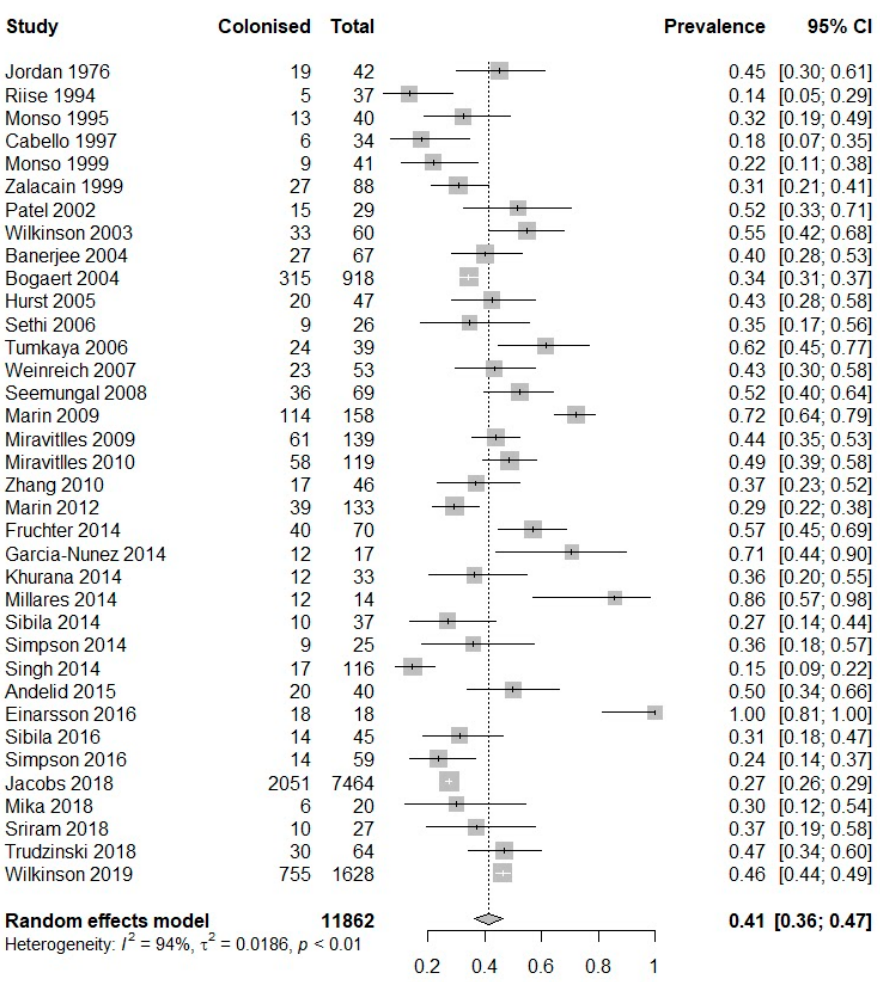
Figure 2. Meta-analysis of prevalence of potentially pathogenic microorganisms in quantitative cultures from stable COPD patients.